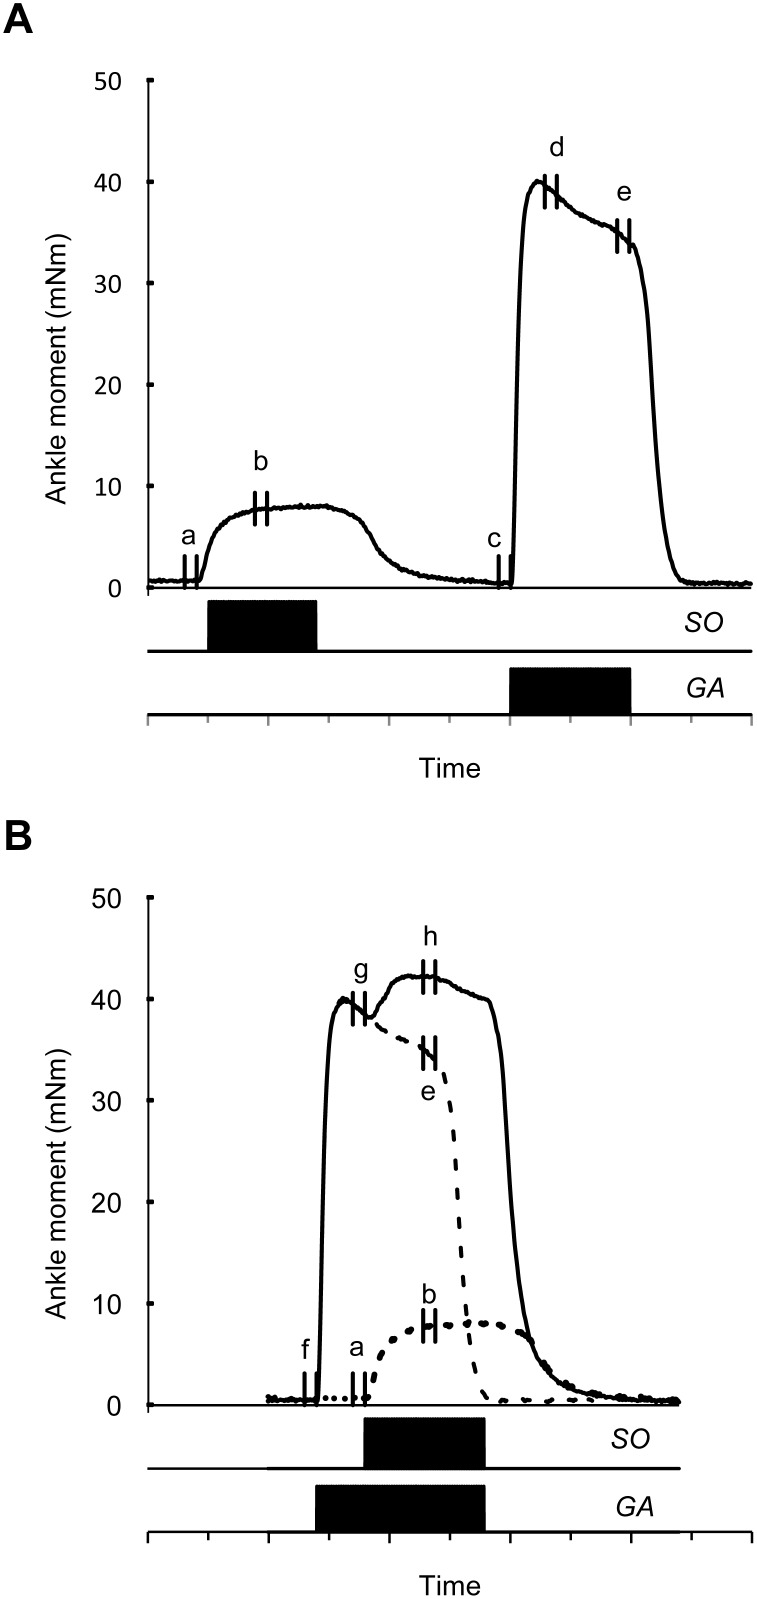
Schematic view of the two stimulation protocols.In this example, ankle joint was positioned at 95°. A) Stimulation (500 ms) of SO and GA separately. B) Simultaneous stimulation (solid line) of GA (700 ms) and SO (500 ms). Dotted and dashed lines represent the individual SO and GA ankle moments as shown in Fig. 3A, respectively. Ankle moments were assessed for several time windows (a–h) by calculating the mean for each 50-ms time windows (see Data analysis).